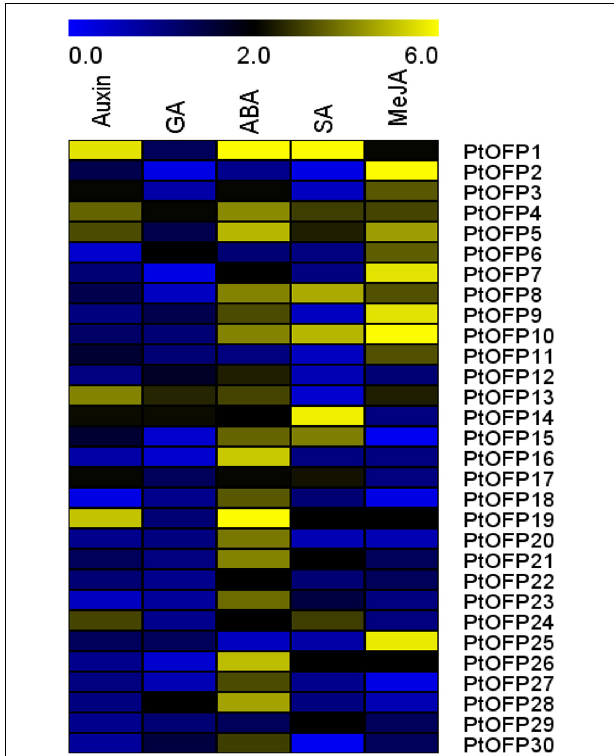
FIGURE 4 | Expression profiles of the 30 PtOFP genes upon different plant hormone treatment. 717-1B4 P. trichocarpa seedlings were treated with 1 µ M IBA, 1 µ M GA3, 100 µ M ABA, 5 mM SA, or 10 µ M MeJA for 3 h. PtUBC was used as a reference gene. The relative expression levels were calculated using the 2 − (cid:49)(cid:49) Ct method. The heatmap was created using MEV. Color scale represents fold